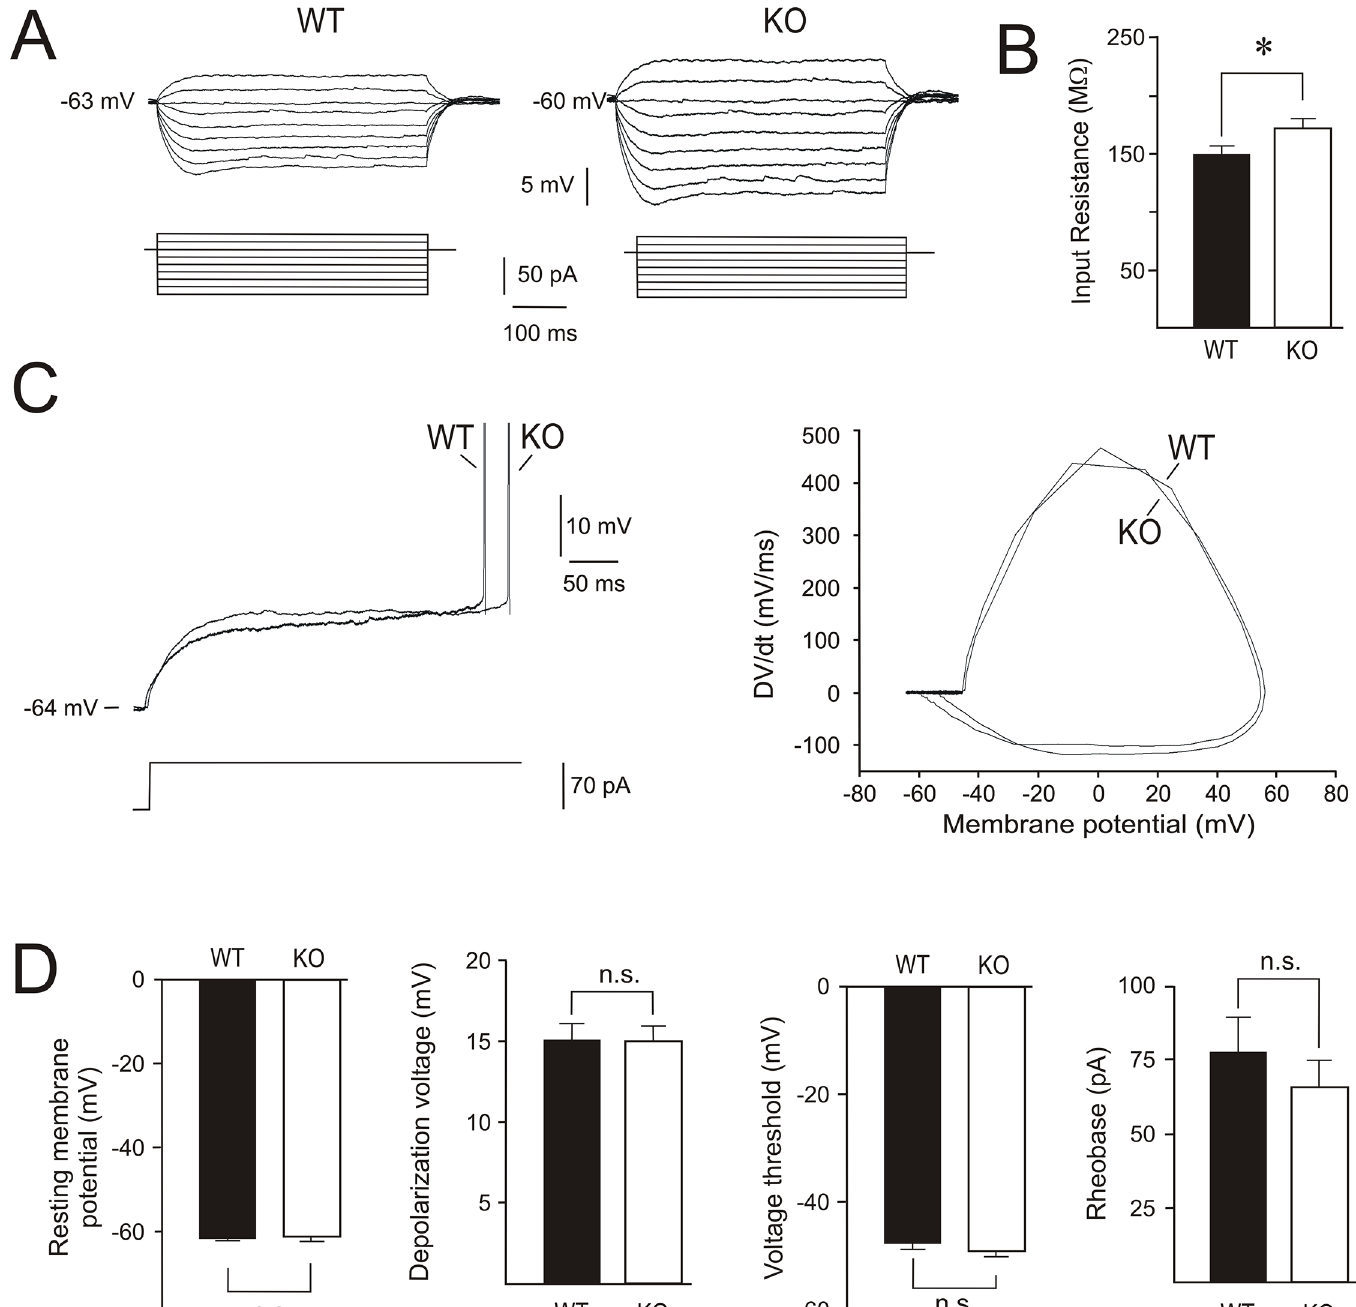
Fig 1. Rheobase is not modified in CA1 pyramidal cells of Fmr1 KO mice. (A) Voltage responses of two representative WT and Fmr1 KO cells to depolarizingand hyperpolarizingcurrent steps. (B) Histogram showinginput resistancein WT and Fmr1 KO cell groups. (C) Representative recordingsof the rheobasethat was 70 pA for both WT and Fmr1 KO cells (left panel). Phase-planeplots to determinethe action potentialvoltagethreshold(right panel). (D) Histogramsshowingresting membranepotential, depolarization voltage, action potential voltage threshold and rheobasein WT and Fmr1 KO cell groups. Calibrations as indicated. In this and followingfigures, histograms show the mean value and standarderror of the mean. Asterisks ( * ) indicatestatistically significantdifferences (P < 0.05).n.s. indicatesnon-significant statistical differences.